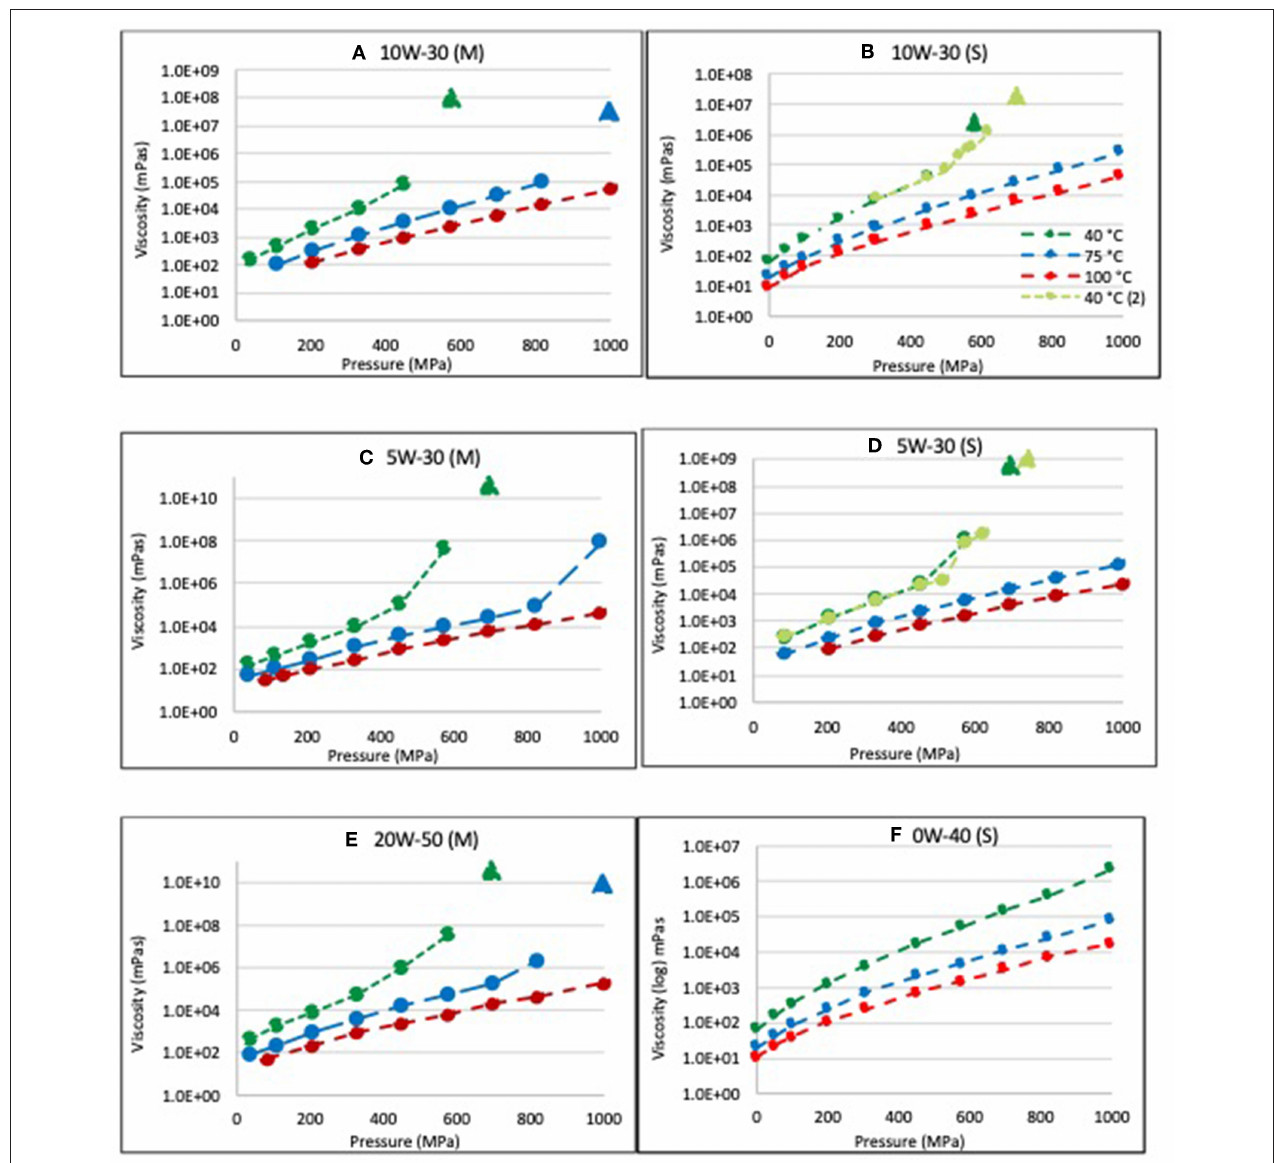
FIGURE 1 | Pressure-temperature-viscosity measurements of mineral oil-based (M) and synthetic oil-based (S) commercial engine oils. (A) 10W-30 (M), (B) 10W-30 (S), (C) 5W-30 (M), (D) 5W-30 (S), (E) 20W-50 (M), and (F) 0W-40 (S). Kinetic effects on the viscosity can be observed in Figures (B,D) in the 40 ◦ C data where the standard procedure of instantaneous pressure application is compared to applying the pressure in increments of 20–30